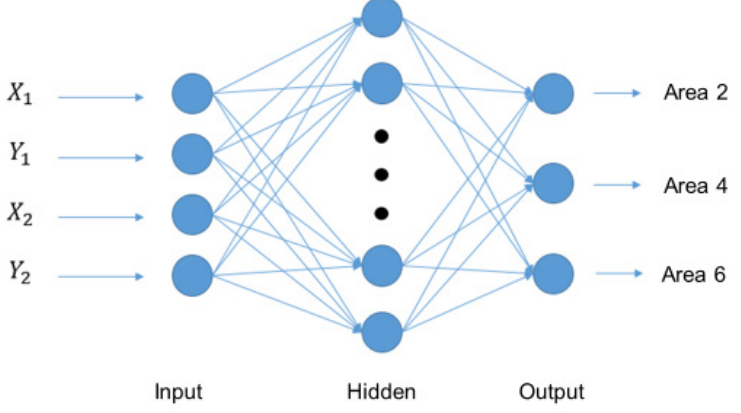
Figure 13. Network architecture of data set 1.